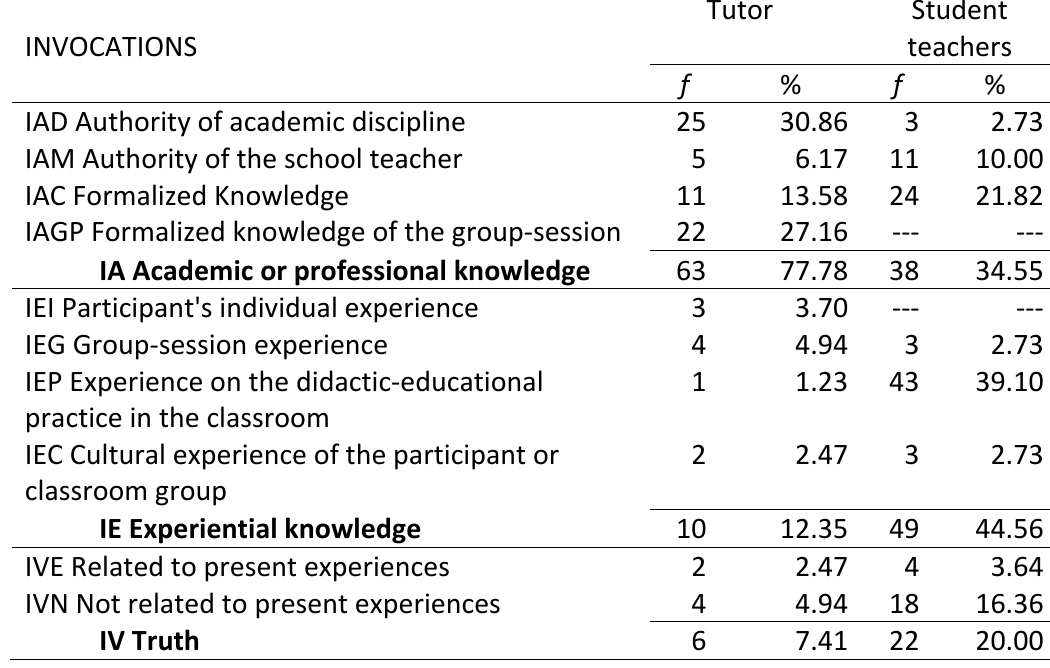
Table 7. Profile of invocations used by the Practicum tutor and the student teachers in case H,